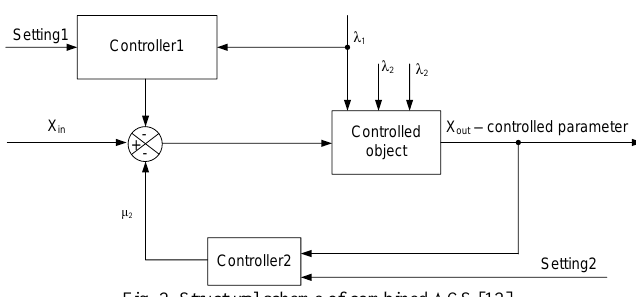
Fig. 2. Structural scheme of combined ACS [12].